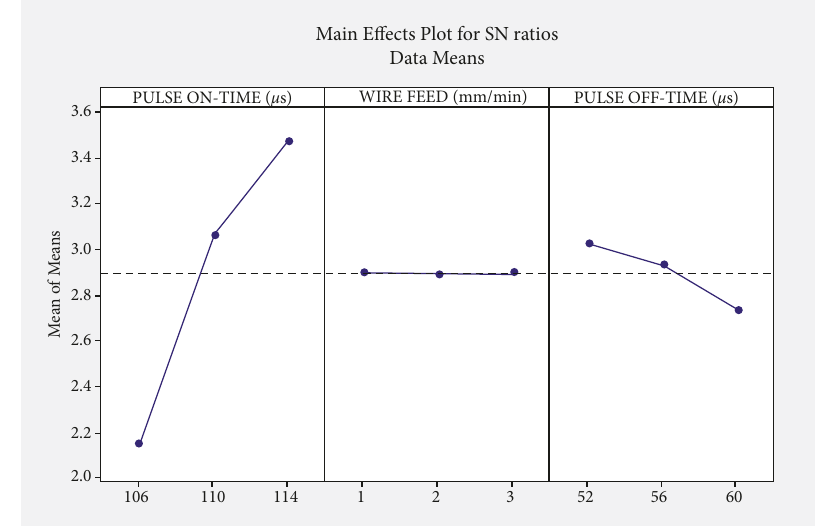
Figure 21: Main effects plot for means.